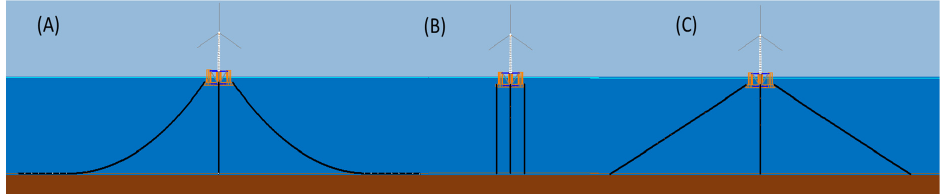
Figure 10. Three types of mooring systems: ( A ) catenary mooring system, ( B ) tension-leg mooring system, and ( C ) semi-taut mooring system